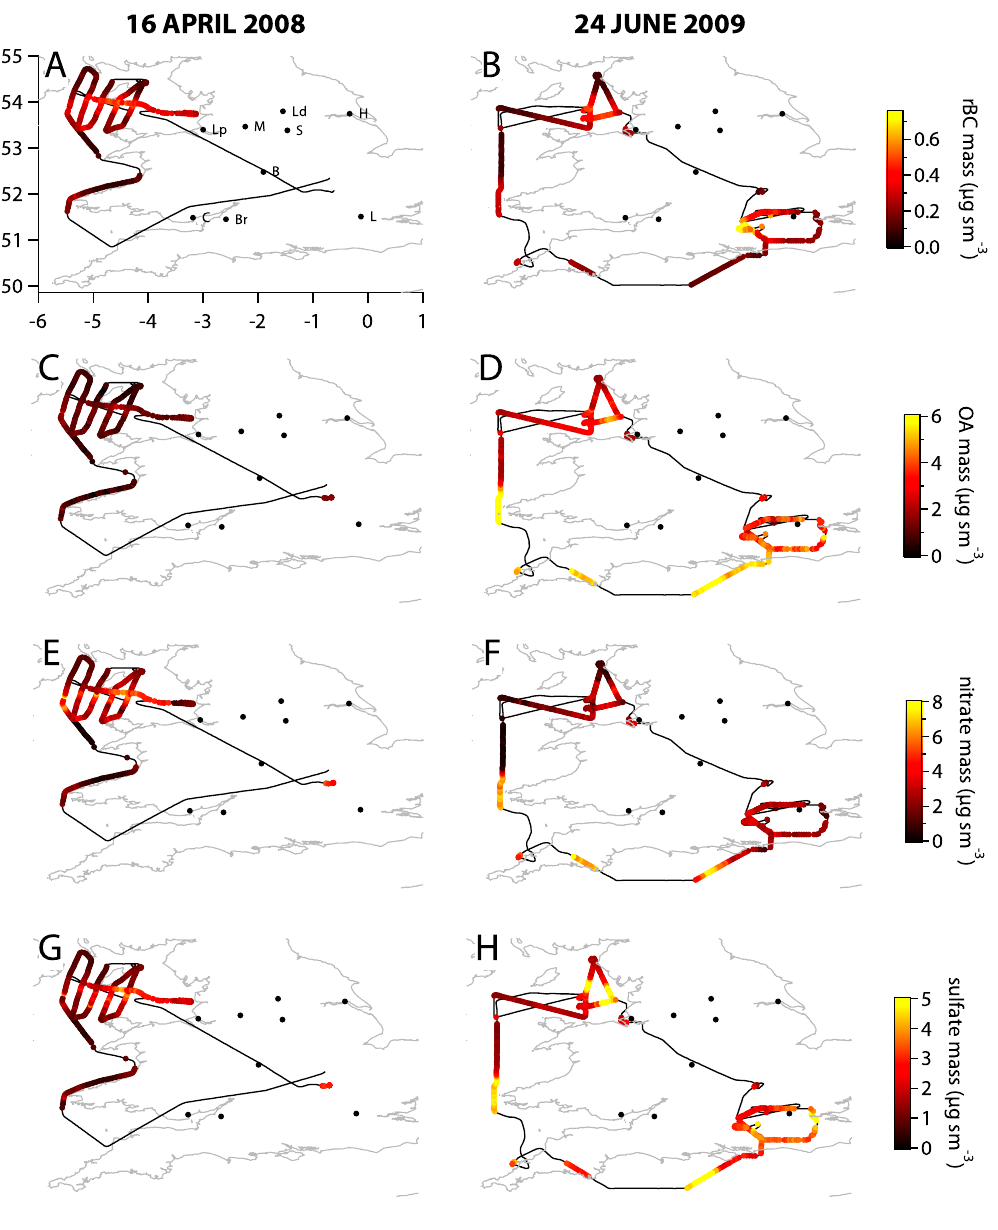
Fig. 3. Maps showing mass concentrations of (a–b) refractory black carbon (rBC), (c–d) organic aerosols (OA), (e–f) nitrate, and (g–h) sulfate measured during level runs inside the boundary layer for each day. Locations of major cities are also shown and labeled as: L, London; B, Birmingham; Br, Bristol; C, Cardiff; Lp, Liverpool; M, Manchester; Ld, Leeds; S, Sheffield; H,